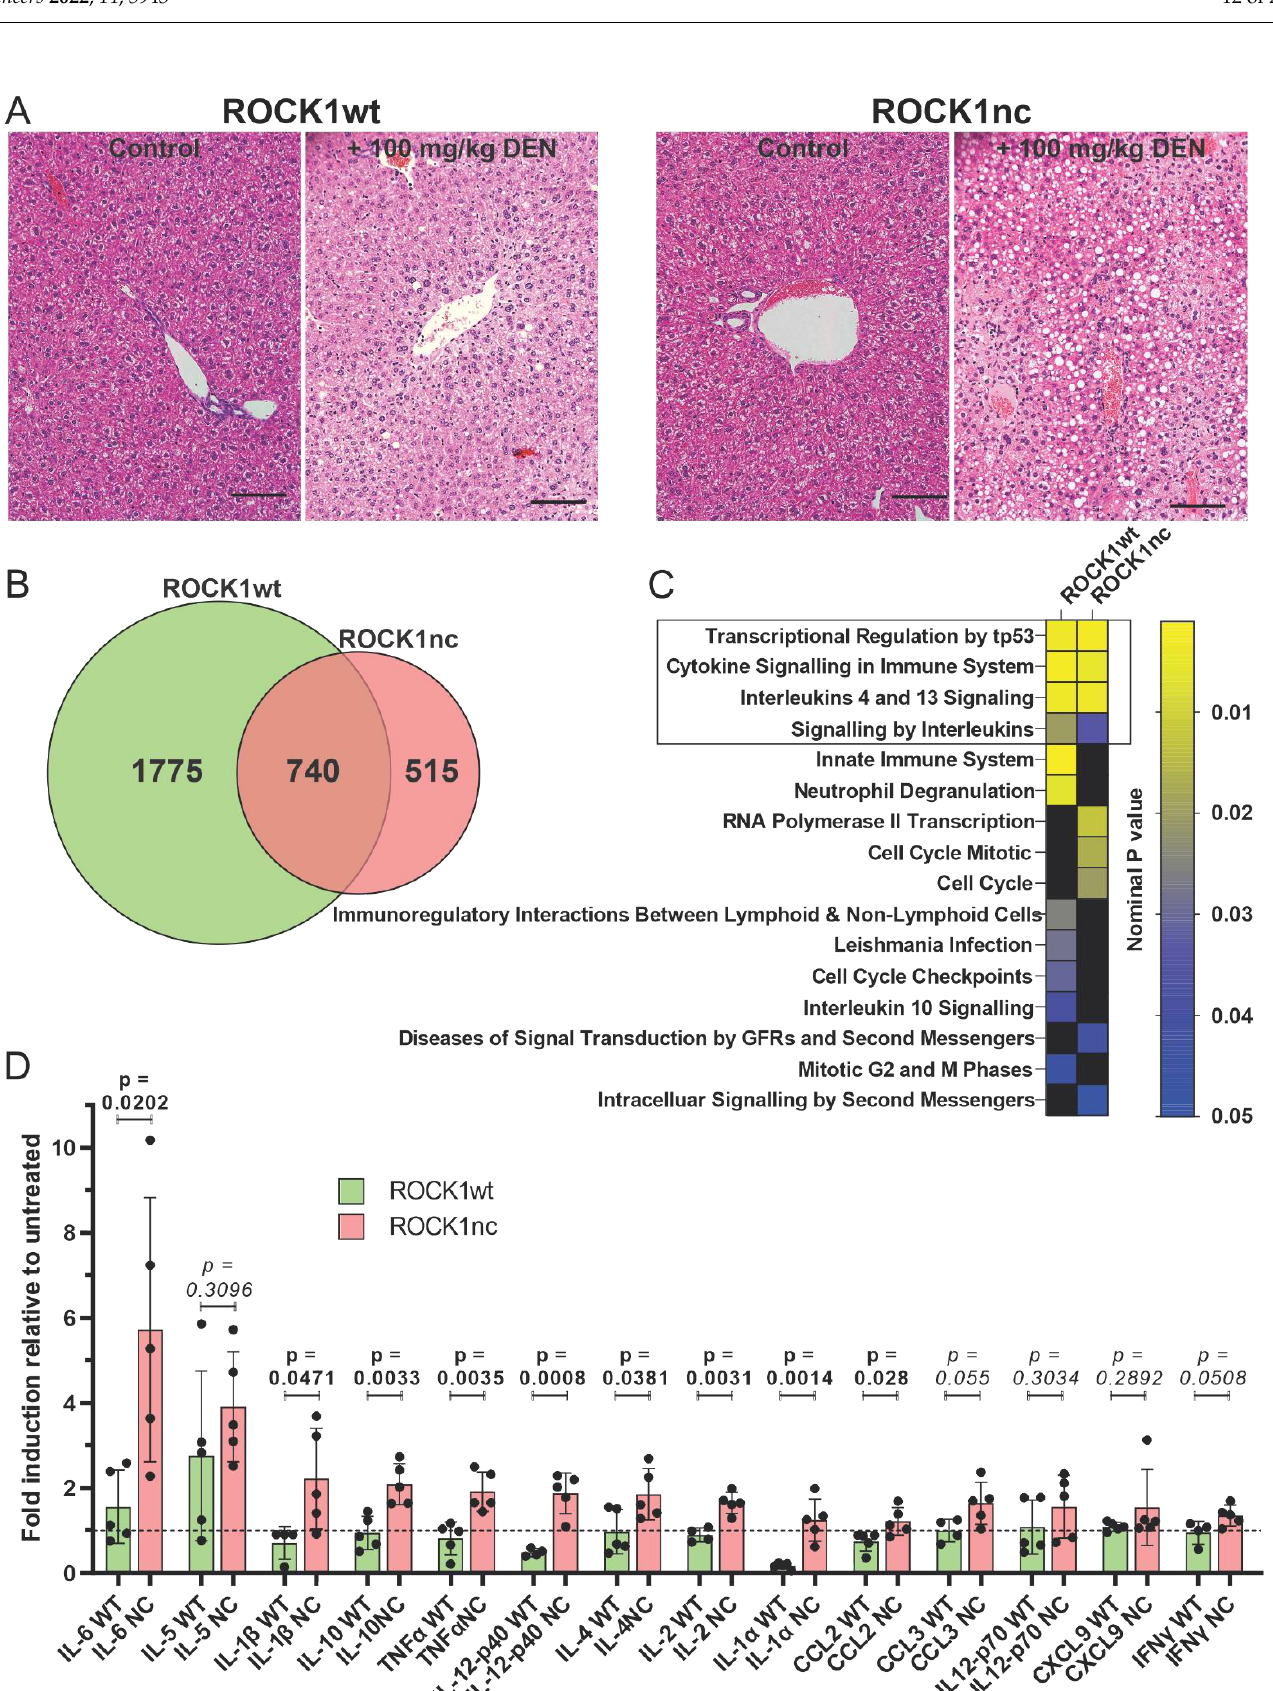
Figure 2. Acute DEN treatment induces steatosis and cytokine/chemokine signalling in ROCK1nc primary hepatocytes. ( A ) Haematoxylin and eosin (H&E) staining of representative liver sections from control ROCK1wt or ROCK1nc mice (left panels) or 72 h after DEN injection (right panels).